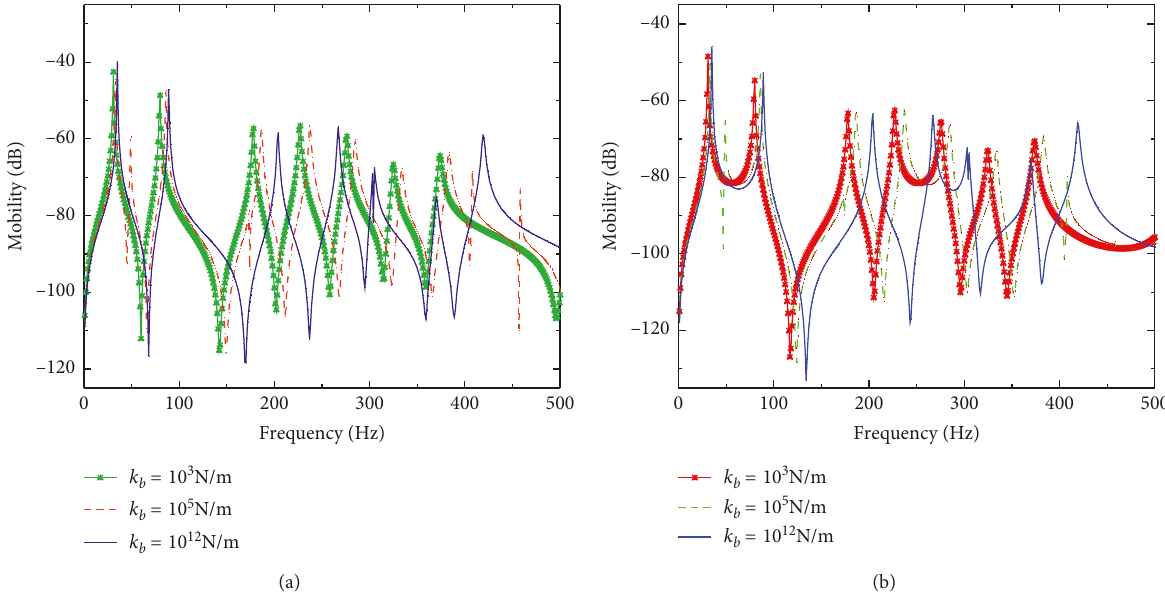
Figure 9: Mobility characteristics of beam-reinforced rectangular plate with different coupling spring stiffnesses ( p 0.5m). (b) Point B (0.5m, 0.5m).